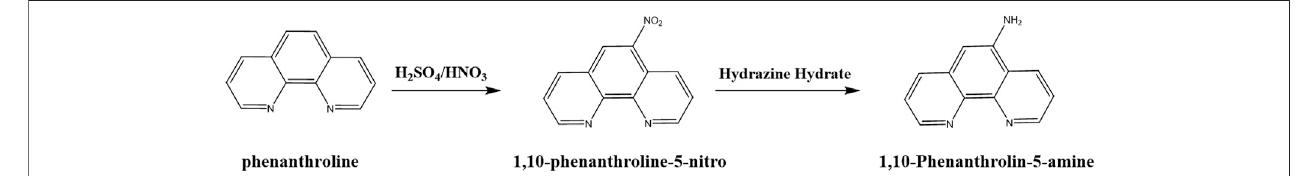
FIGURE 1 | The synthetic routes and structures of phenanthroline, Phen-NO 2 , and Phen-NH 2 .